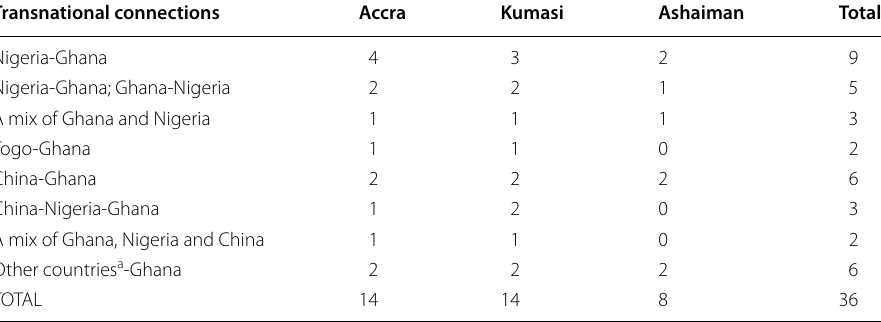
a UK, Japan, UAE, Germany, Singapore,